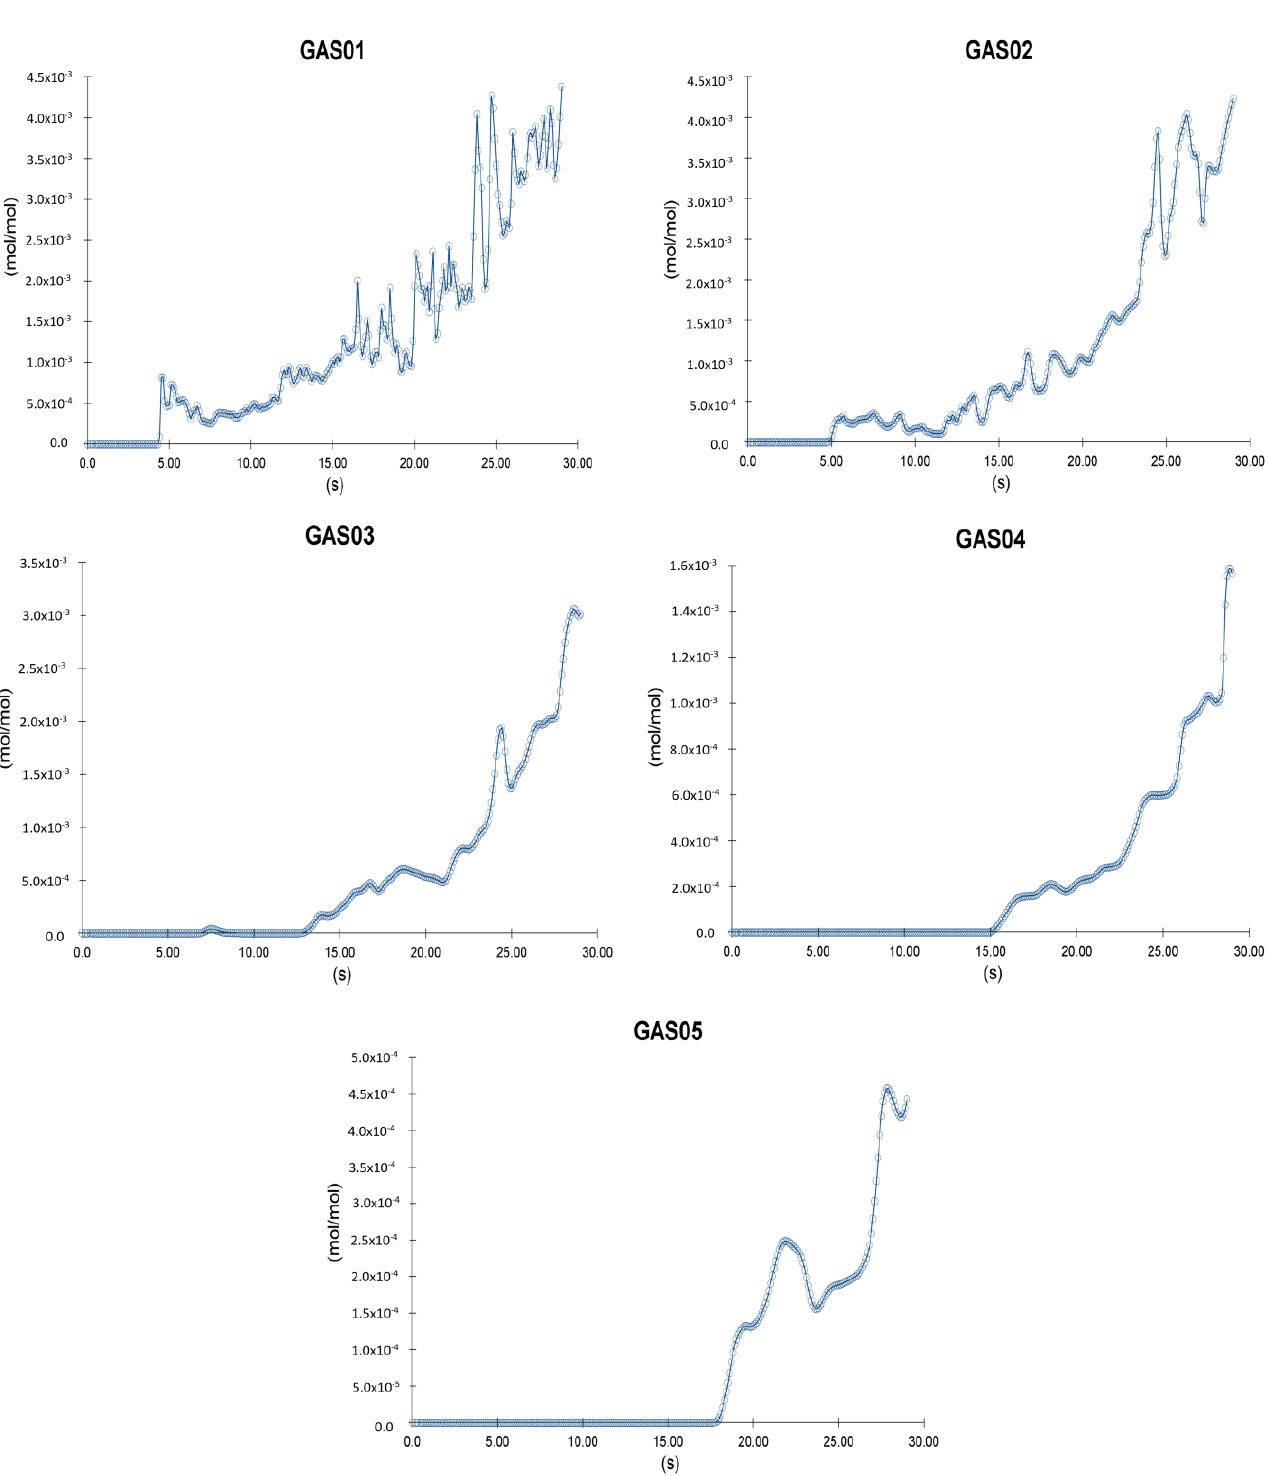
Figure 12. CO volume fraction diagrams.